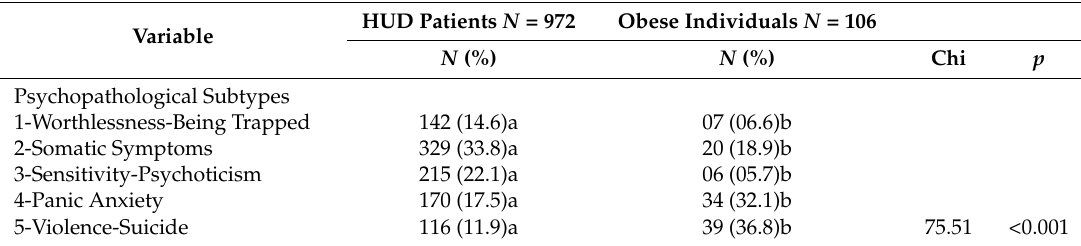
Table 2. Psychopathological typology in Heroin Use Disorder (HUD) patients and obese patients.